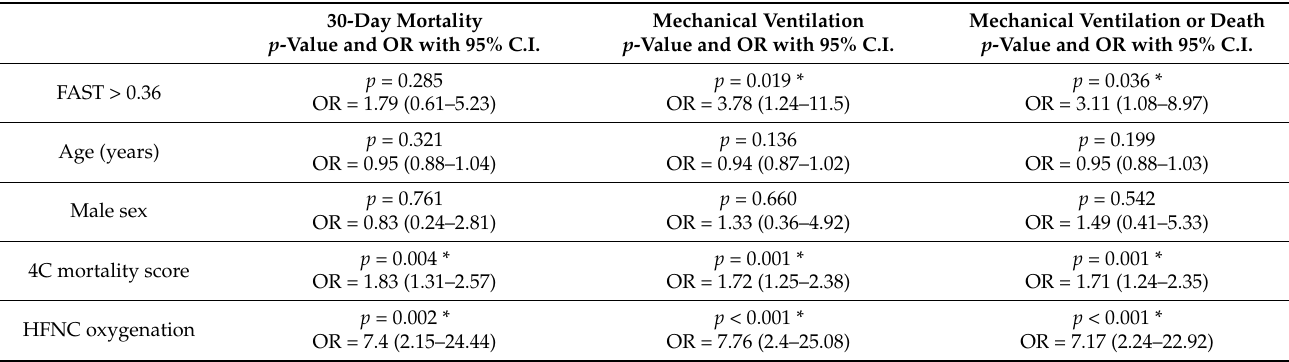
Table legend: BMI, body mass index; FAST, FibroScan-AST score; LSM, liver stiffness measurement; IQR, interquartile range; HFNC, high-flow nasal cannula. * Statistically significant at level p <